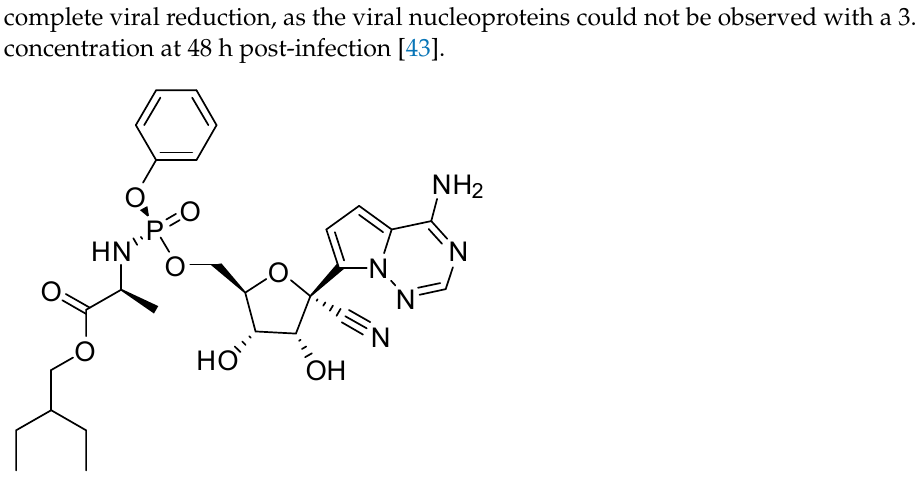
Figure 9. The molecular structure of Remdesivir ® .